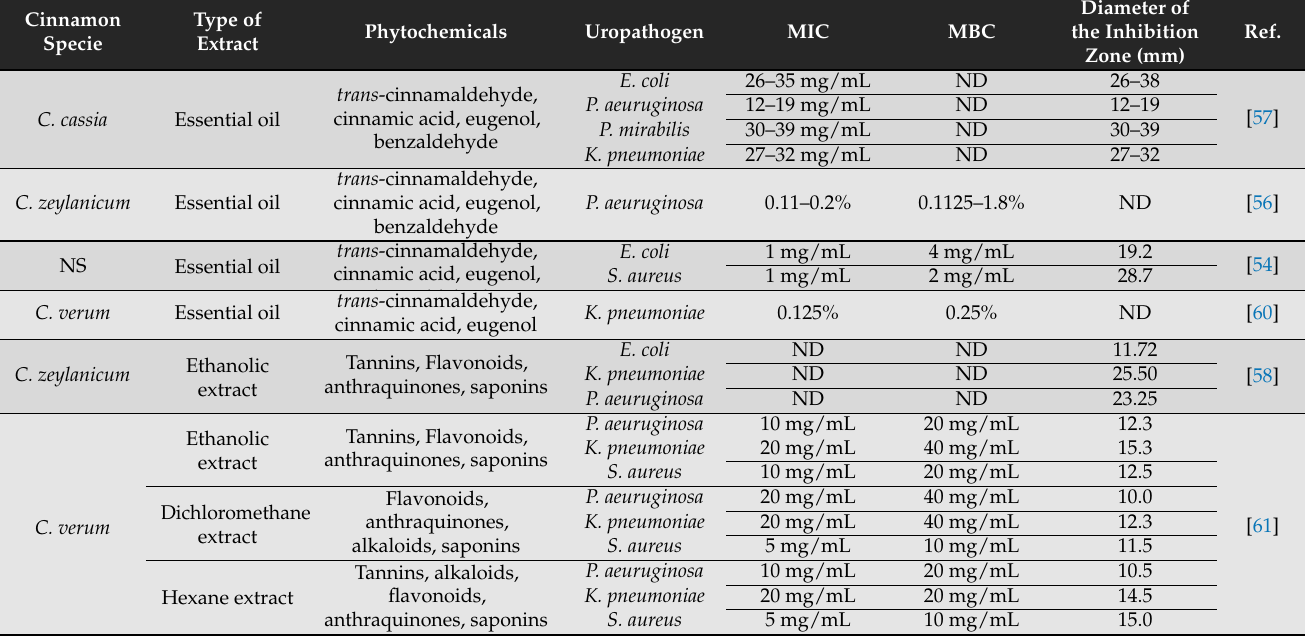
Table 1. Antimicrobial activity of cinnamon bark